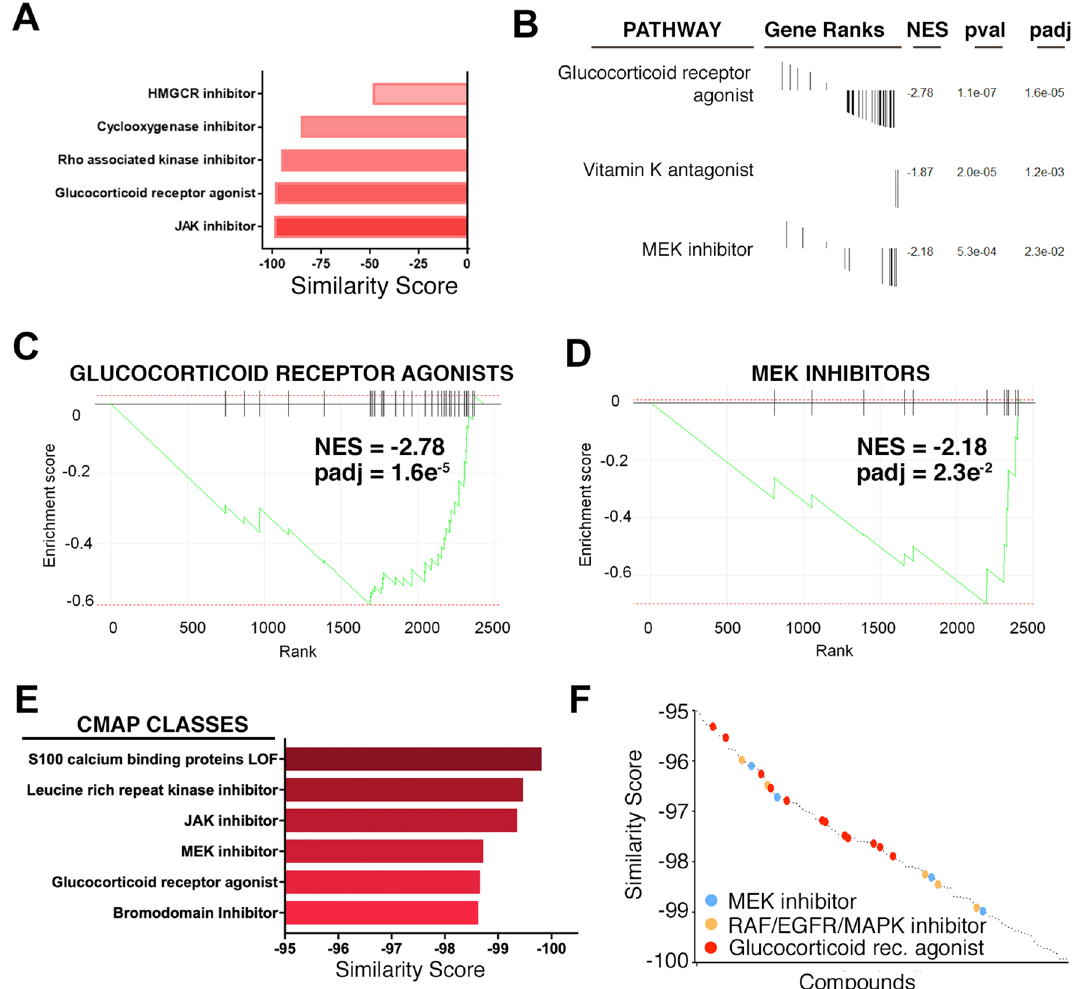
Figure 2. Compounds triggering transcriptional signatures opposed to the COVID CS . ( A ) COVID CS similarity scores for drug types (CMap Classes) already under study for the treatment of the COVID-19 CS. ( B ) Drug GSEA analysis of compound classes with a transcriptional signature that negatively correlates to the COVID CS . Enriched pathways with padj value < 0.05 are shown, as well as their gene ranks, Normalized Enrichment Scores (NES), p-value (pval) and adjusted p-value (padj). ( C , D ) Enrichment plots of Glucocorticoid receptor agonists ( C ) and MEK inhibitors ( D ) resulting from the Drug GSEA analysis mentioned in ( B ) illustrating the overall negative correlation between the transcriptional signatures triggered by these compounds and the COVID CS . ( E ) Similarity scores of the top CMap Classes with an associated transcriptional signature that negatively correlates to the COVID CS . ( F ) Similarity scores of specific compounds with a COVID CS similarity score lower than − 95. MEK inhibitors (blue), RAF/EGFR/MAPK inhibitors (orange) and glucocorticoid receptor agonists (red) are highlighted by the indicated